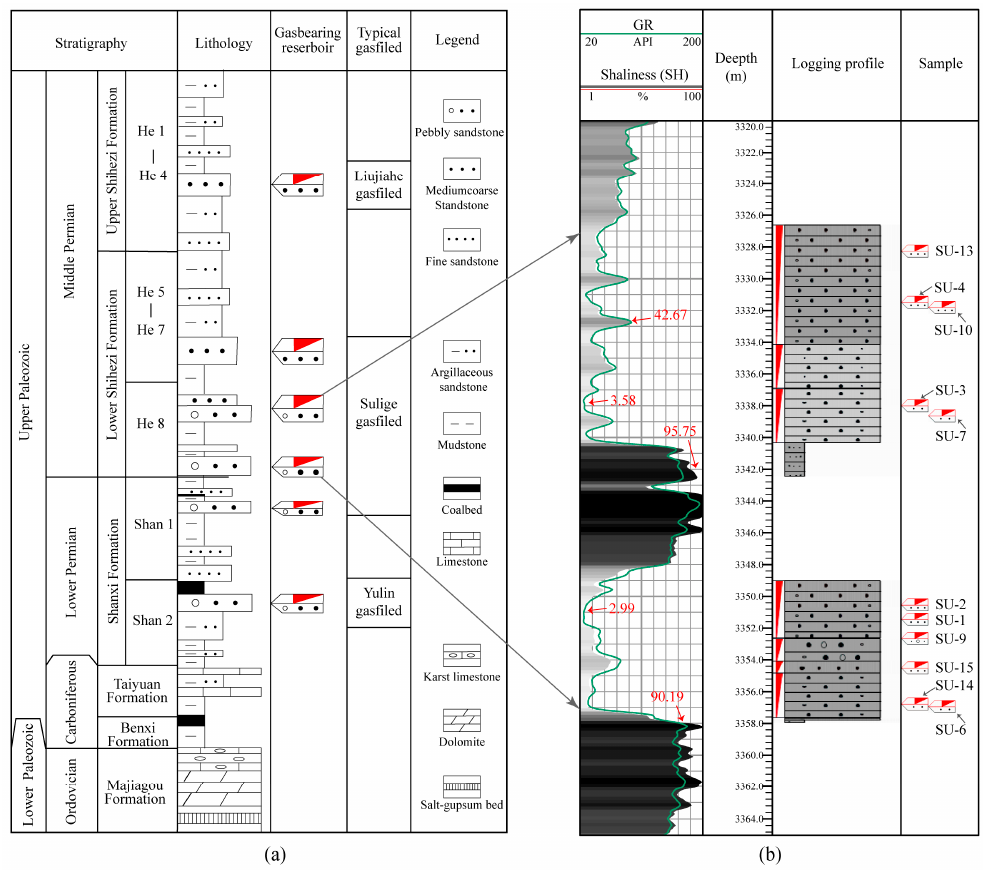
Figure 2. Schematic diagram of sampling location. ( a ) Generalized stratigraphic columns of the Shihezi Formation (modified from reference [47]); ( b ) sampling depth and its corresponding logging profile and gamma (GR ) curve.